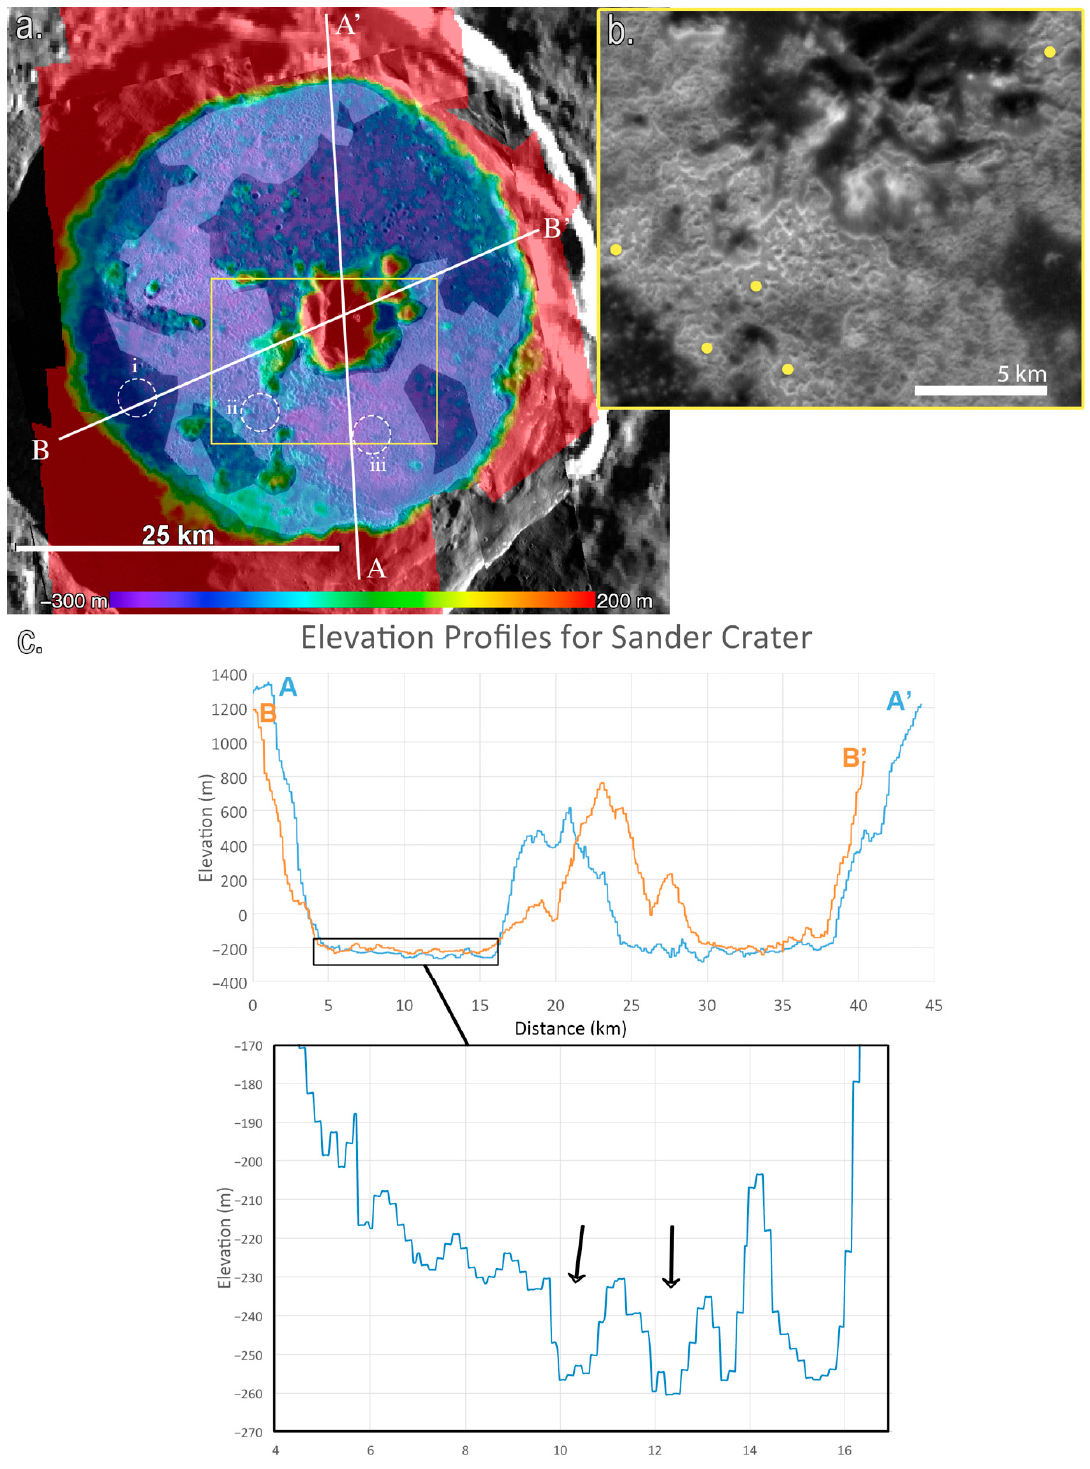
Figure 12. ( a ) Sander crater overlaid with a color-shaded elevation map. Polygons show hollowed areas of floor investigated here; dotted circles mark characteristic units of pitted terrain (i), smooth floor (ii), and bright knob/deep floor (iii). ( b ) Detail of SANDR18 orthophoto showing a portion of the crater floor and central peak. Yellow dots indicate the hollows measured for this study. See Appendix A for stereo pair details. ( c ) Elevation profiles. Inset profile shows a detail of bright knob/deep floor area; arrows indicate distinct hollows.